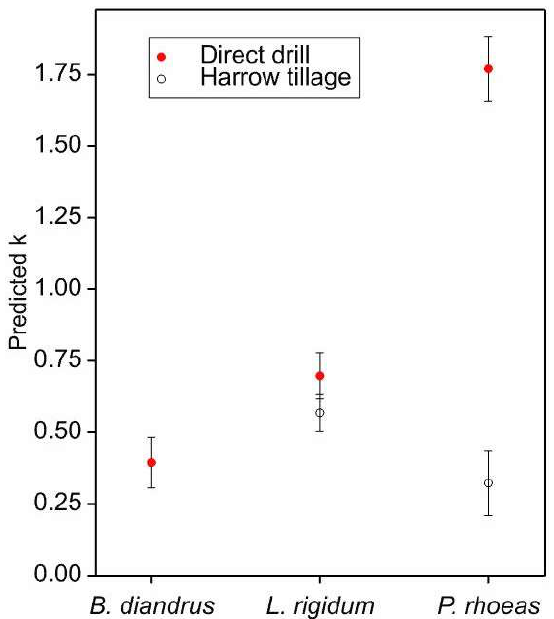
Figure 1. Predicted values of the k parameter of the negative binomial distribution when fitted to data on the weed cover of B. diandrus , L. rigidum and P. rhoeas from seven fields in North-eastern Spain measured over the 3 years. The bars indicate the standard errors. The numbers of field by season observations for each species and tillage combination are as follows. For direct-drilled fields: B.